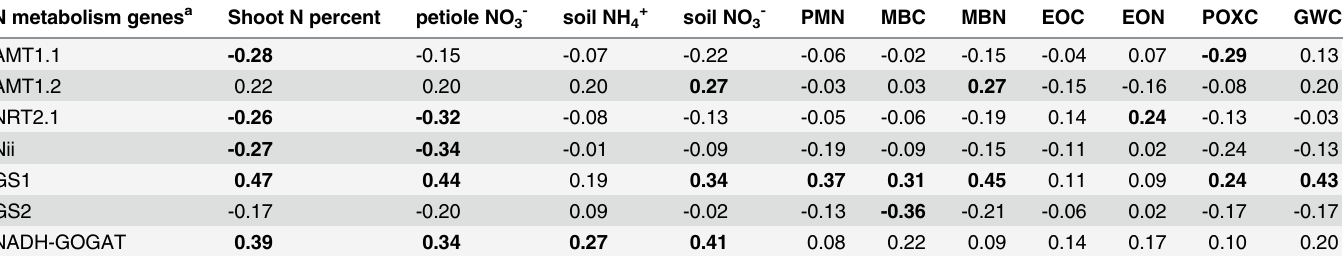
Table 3. Pearson correlation coefficients between root expression of key N metabolism genes a and plant and soil variables b measured across 13 organic Roma-type tomato fields in Yolo Co., California, USA. N metabolism genes